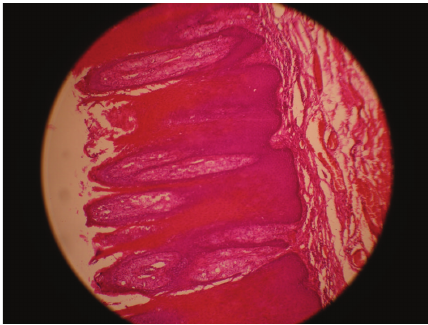
Figure 4: Showing foam cells with strong cytoplasmic CD68 immunostaining. The epithelial cells were negative (IHC stain